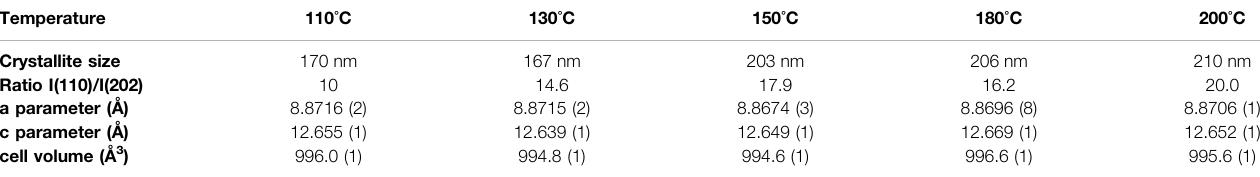
TABLE 2 | Evolution ofcrystallite size, the ratio between (110) and (202) diffraction peak intensities and the ratio between (110) ofMAPI and (001) of PbI 2 as a function ofthe annealing temperature of MAPI fi lms annealed between 110 – 200 ° C.